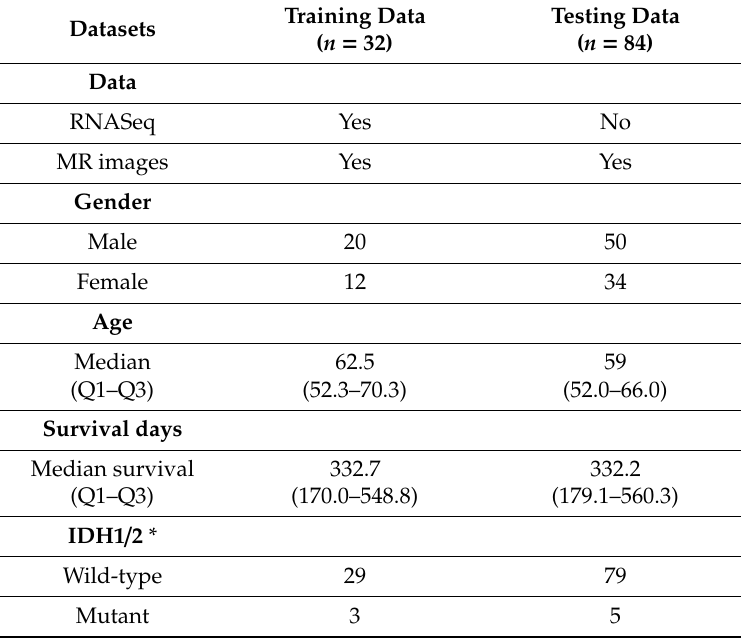
Table 1. Demographic characteristics of patients whose data were used in the training and testing data sets.